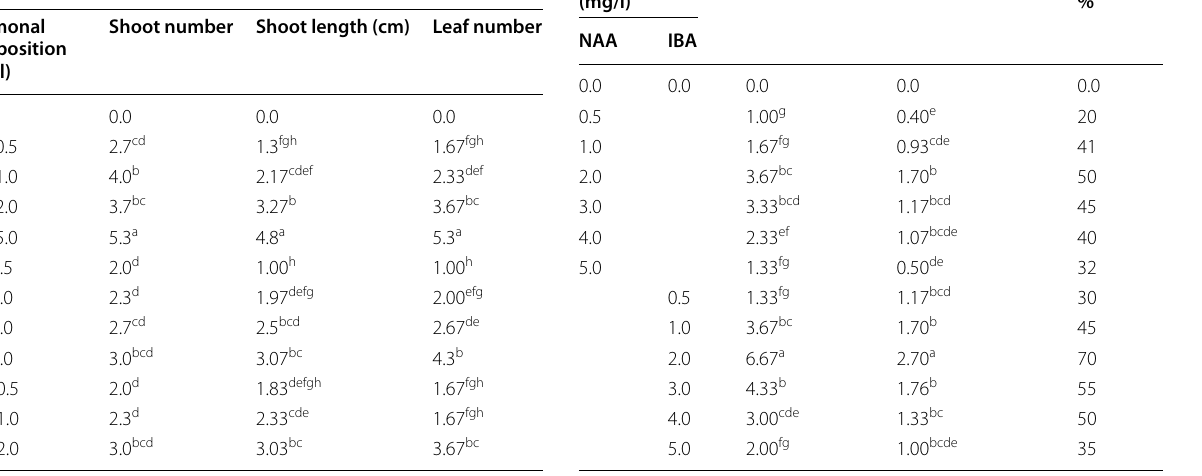
Table 1 Effect of cytokinins on shoot proliferation of Phoebe goalparensis